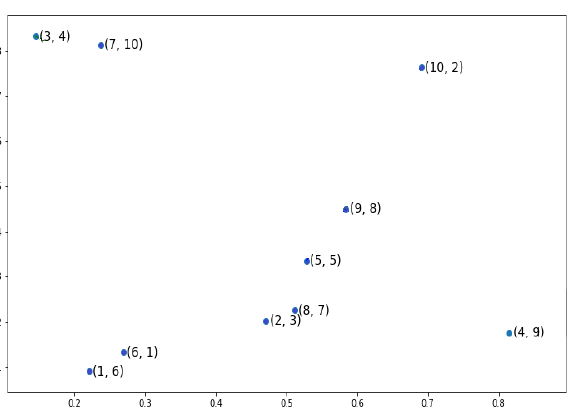
Figure 2. Traveling salesman Problem with 10 cities, chromosomes. The vertices depict the cities where the first index refers to the position of the city inside the chromosome while the other index refers to the city label. An edge can be formed between each two sequential cities to show the path which the traveling salesman should